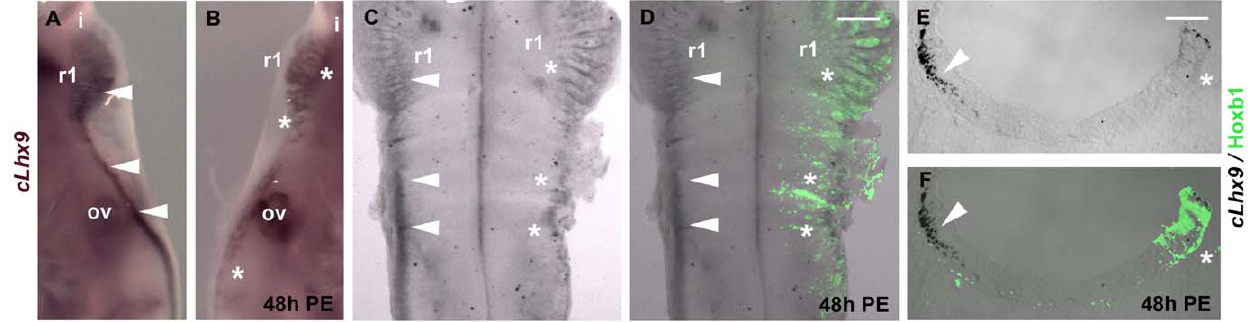
Figure 5. Expression of Lhx5 in the chick hindbrain after Hoxb1 gain of function experiments. (A – F) Expression of Lhx9 in whole mount (A, B), flat mounted hindbrains (ventricular view) (C, D) and r1 transverse sections (E, F) of chick embryos electroporated at stage HH 10–11 and analyzed 48 h PE by Lhx9 in situ hybridization alone (A, B) or in combination with Hoxb1 immunofluorescence (C – F). Lxh9 is expressed in the mantle layer of dorsal r1 in a thick stripe that subsequently thins out along the rhombic lip of the rest of the hindbrain (arrowheads A, C, E, F). This expression is lost at sites of Hoxb1 ectopic expression (asterisks B, D, E, F). Scale bar corresponds to 300 m m in C, D and to 150 m m in E, F.